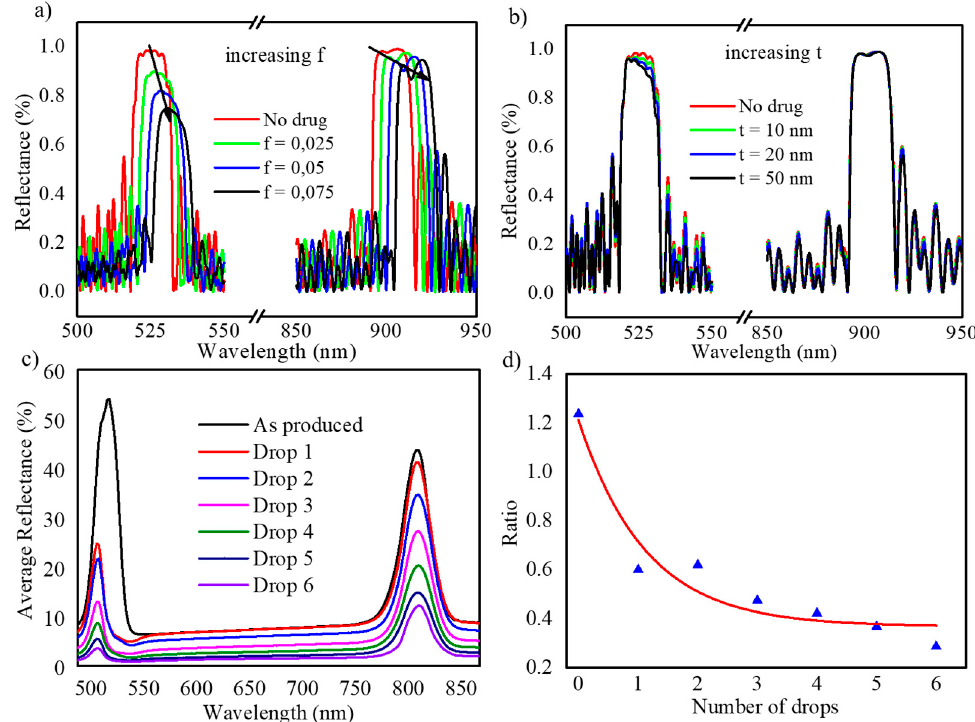
Figure 8. ( a ) Reflectance spectra obtained by numerical simulation considering different volume fractions (f) of a cargo molecule filling the NAA-GIF pores, ( b ) calculated reflectance spectra for different thickness (t) of a cargo molecule layer on the NAA-GIF surface, ( c ) UV/VIS reflectance spectra for NAA-GIFs with N = 200 periods measured after each cycle of the drop/dry experiment; ( d ) points: ratio of the maximum reflectance of the signal band to the maximum reflectance of the reference band, as obtained from the spectra in ( c ) as a function of the number of drop/dry cycles. The line is a non-linear fit to illustrate the trend.